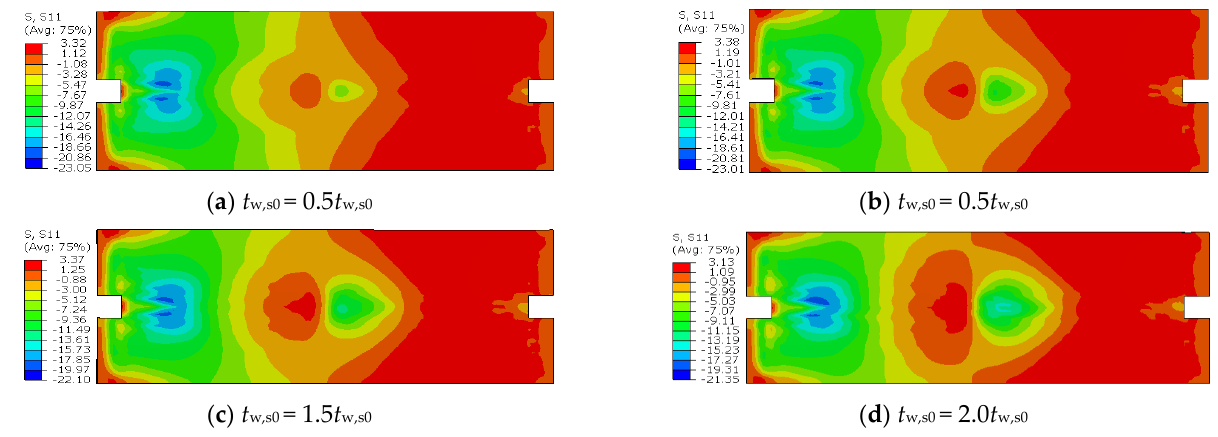
Figure 23. Stress nephograms of a concrete slab for different t w,s values.